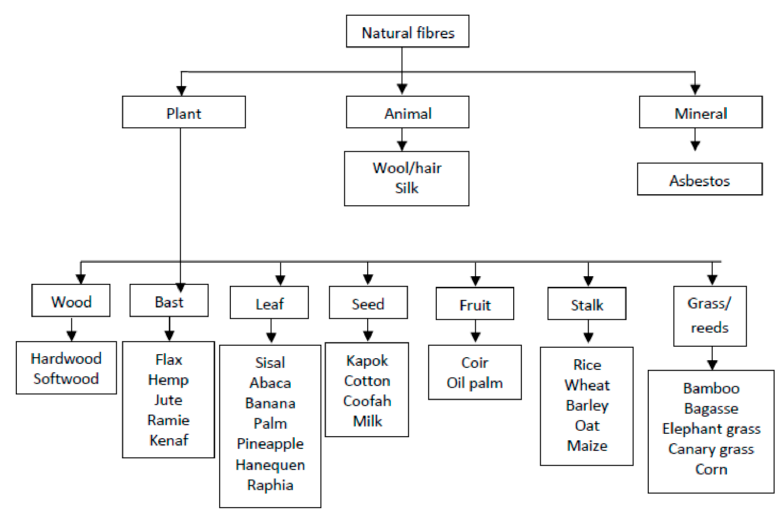
Figure 1. Categories of natural fibres [7,9,18].